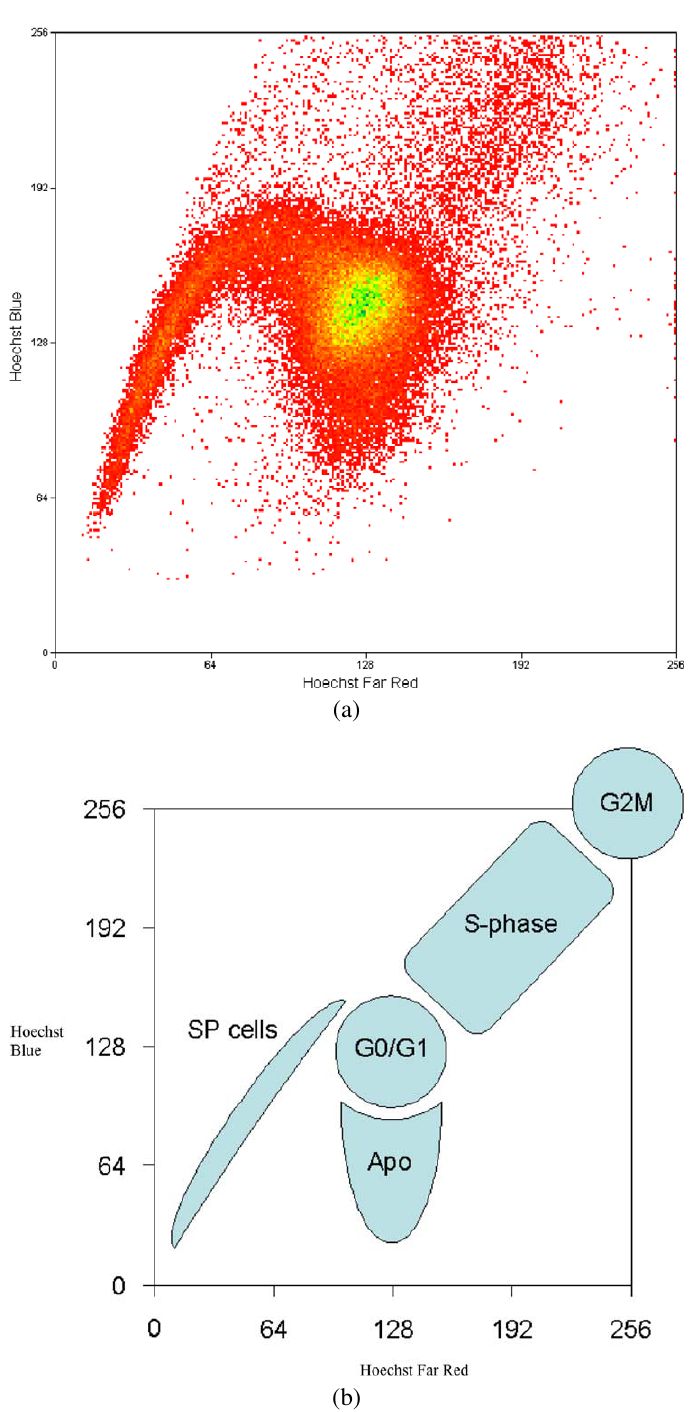
Fig. 1. Hoechst 33342 SP analysis of unpurified human BM on a MoFlo R (cid:1) cell sorter equipped with an Enterprise II water-cooled ion laser emitting at 351 nm (30 mW of laser power). Representative dotplot for Hoechst Blue vs. Hoechst Red simultaneous emission of a human BM sample containing SP cells (a). Schematic dotplot showing distribution of events (b). Characteristic Ho342 dye staining profiles in presence of the specific ABCG2 inhibitor, fumitremorgin C